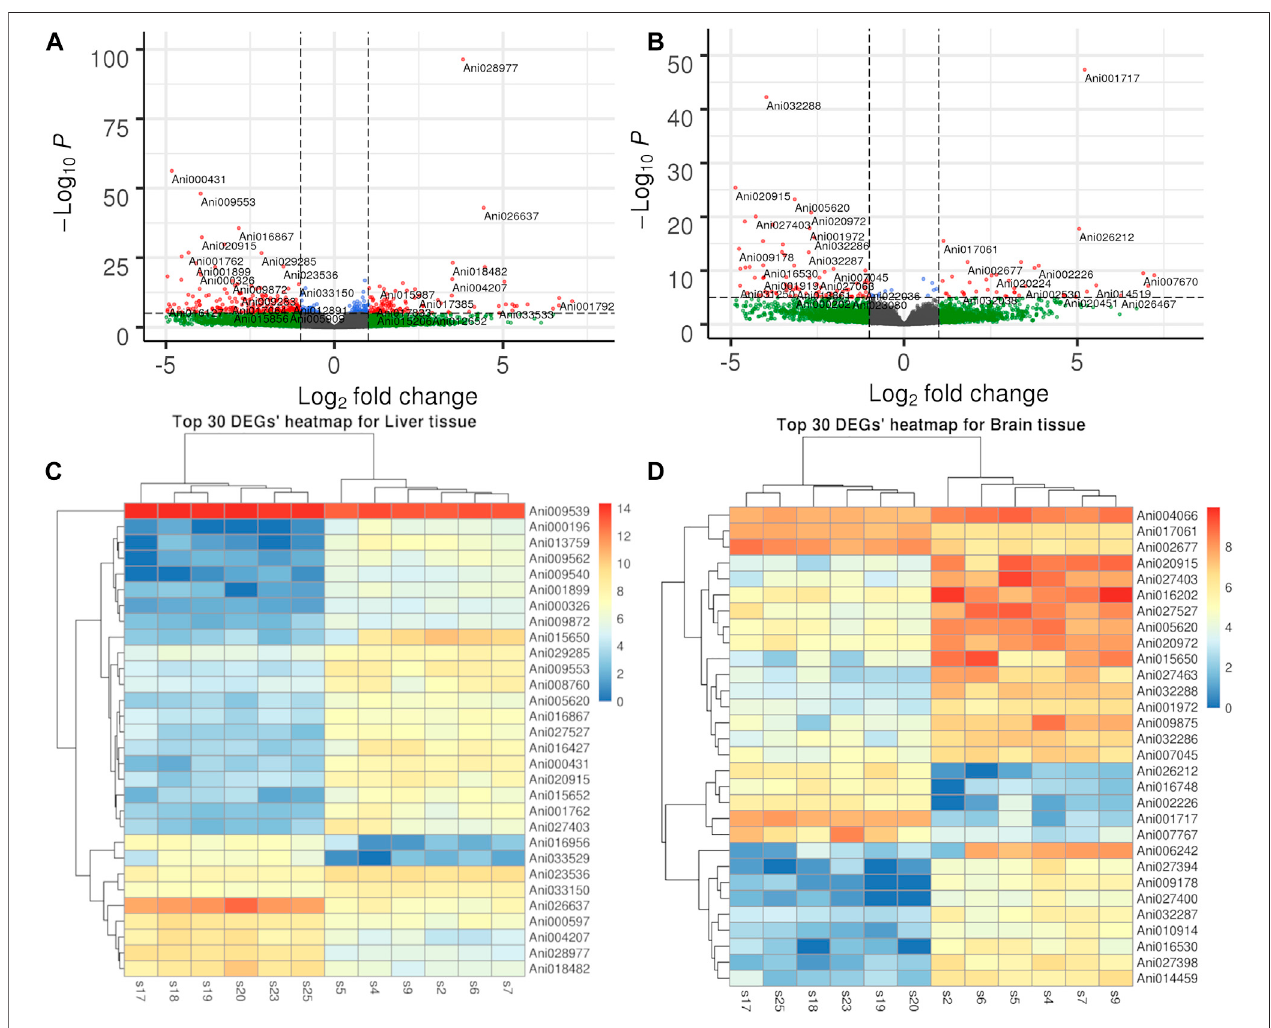
FIGURE 2 | Volcano plot and heatmap of DEGs in liver and brain tissues. (A) . Volcano plot of DEGs in liver tissue. (B) . Volcano plot of DEGs in brain tissue. (C) . Hierarchical clustering of top 30 DEG in liver tissue. (D) . Hierarchical clustering of top 30 DEG in brain tissue.